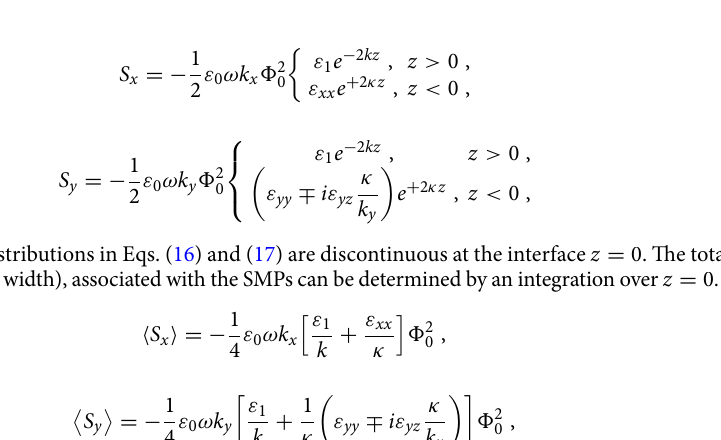
Figure 7. Normalized profile S x ( z ) of SMP modes of a flat magnetized electron gas-vacuum interface, as 2 , k x > 0 , and k y is a positive constant, corresponding to the labeled obtained from Eq. (16) when k x / k y = B 0 e x . ( b ) B 0 B 0 e x points in Fig. 3a. ( a ) B 0 = − = +